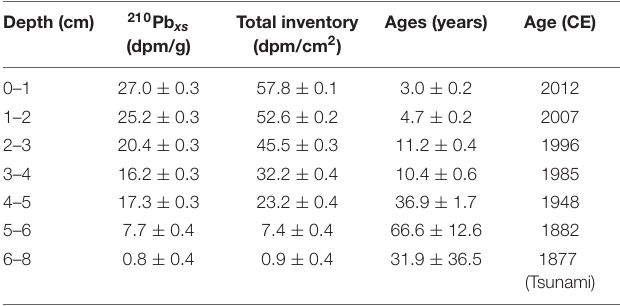
Frontiers in Marine Science |